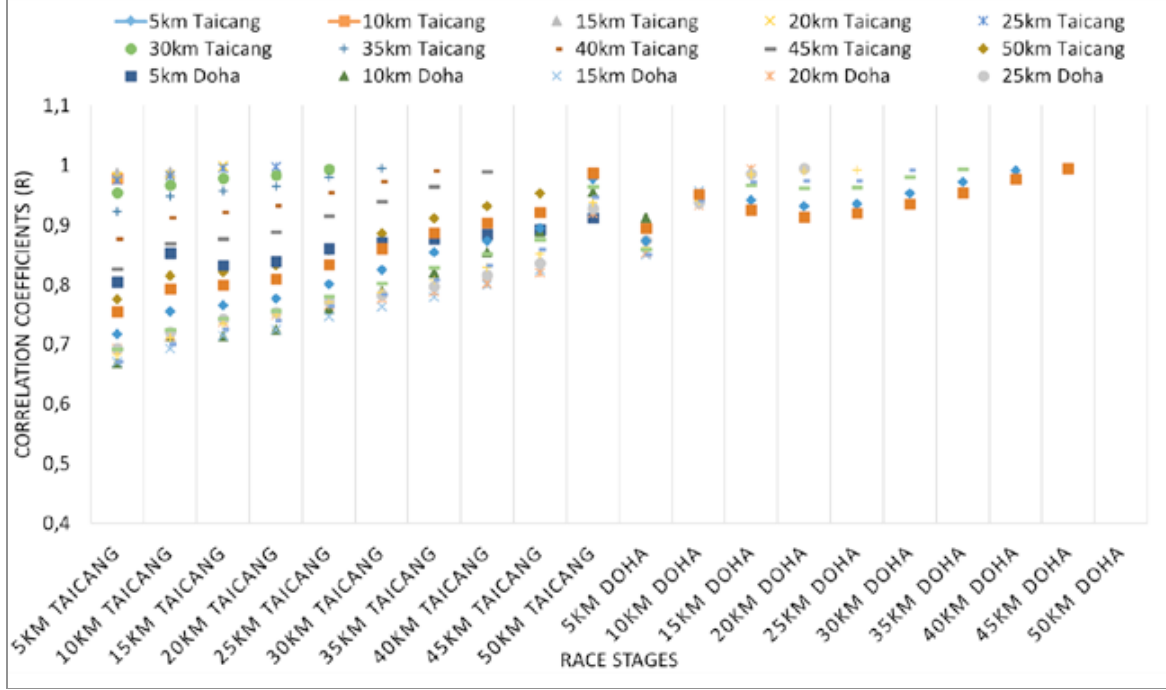
Figure 7 . Correlation coefficients (r) between the performance times averages of the race stages in both Table 8 . Analysis of variance (ANOVA: Single Factor) between performance time averages of the race stages in WAC2019.